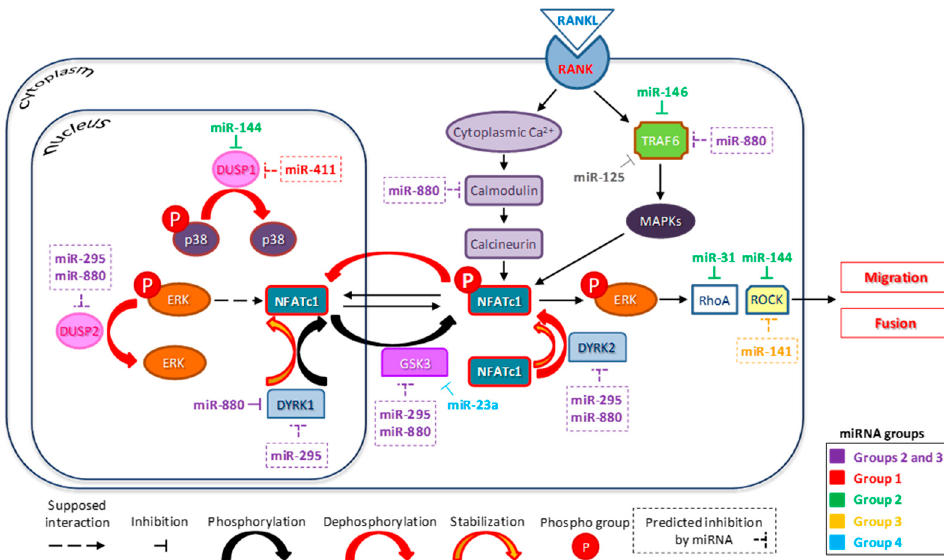
Figure 4. Diagram of the hypothetical mechanism controlling osteoclast differentiation involving miRNAs, ERK phosphorylation, and NFATc1 expression. MiRNAs differentially expressed in the PCR array are grouped as described in the text, i.e., Group 1 (untransfected/upregulated), Group 2 (untransfected/downregulated), Group 3 (transfected/upregulated), and Group 4 (transfected/downregulated). Solid arrows, known interactions (from literature or present results); dashed arrow, speculative interactions; − |, inhibition; and dashed rectangular, miRNAs predicted by our bioinformatic analyses.